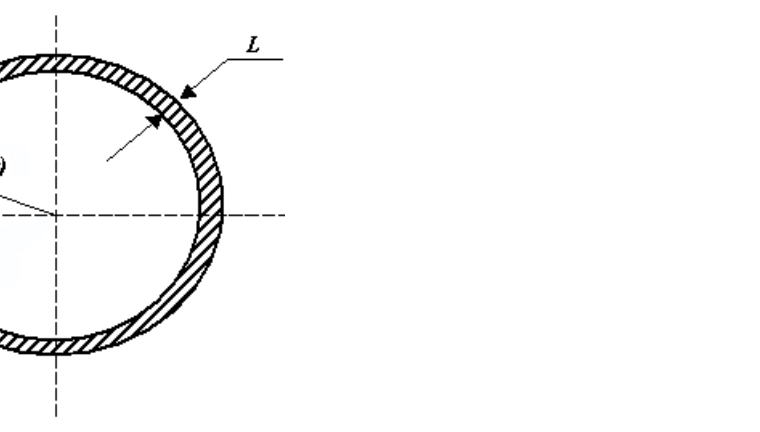
Figure 1. Schematic representation of a model for cyclic extraction of particles with the characteristic size L from a droplet of the liquid with the variation in its radius R ( t ) under the effect of ultrasound.